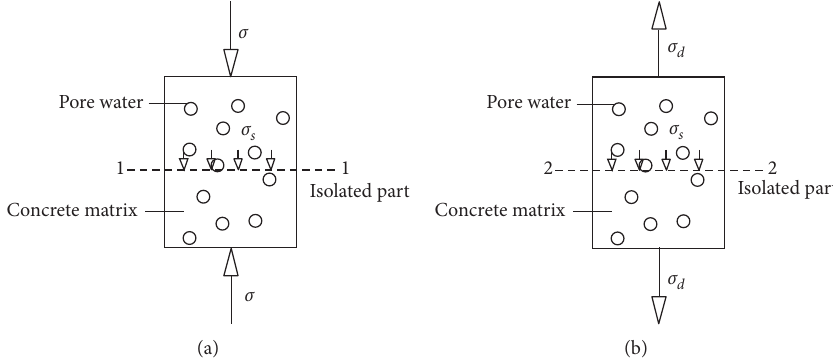
Figure 11: Schematic diagram of effective stress principle of